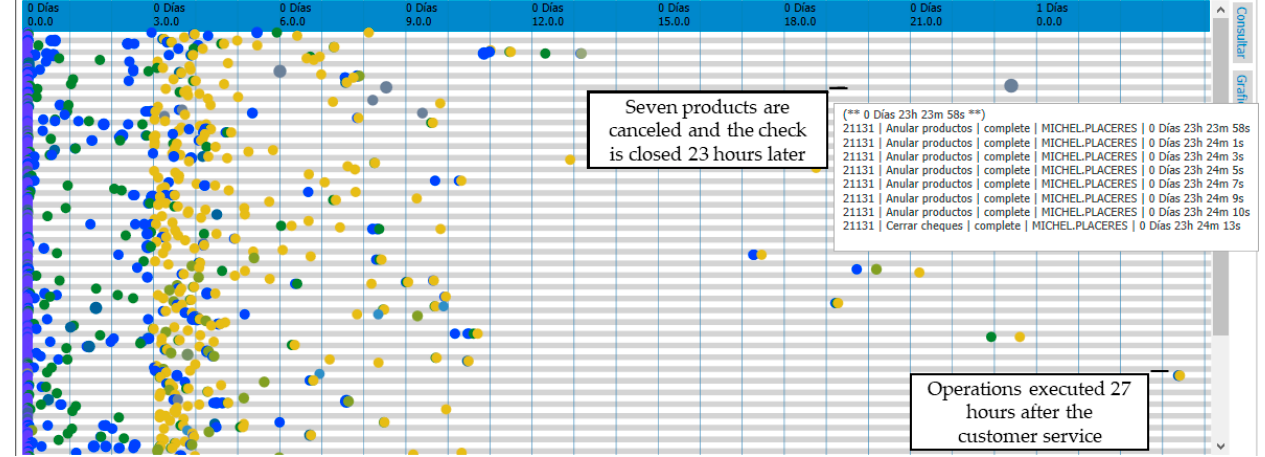
Figure 7. View of the instances operating outside service hours.